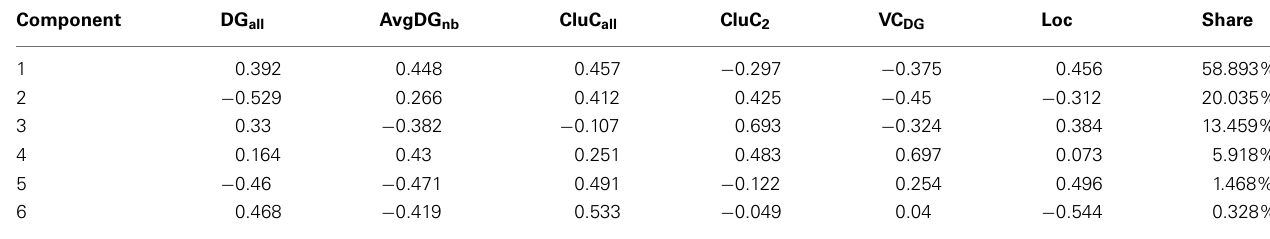
For each principal component, the contribution of the feature vector is given for each feature, and by its Share (percentage of the variance of a component of the total variance of the 6-dimensional feature space; Echtermeyer et al.,